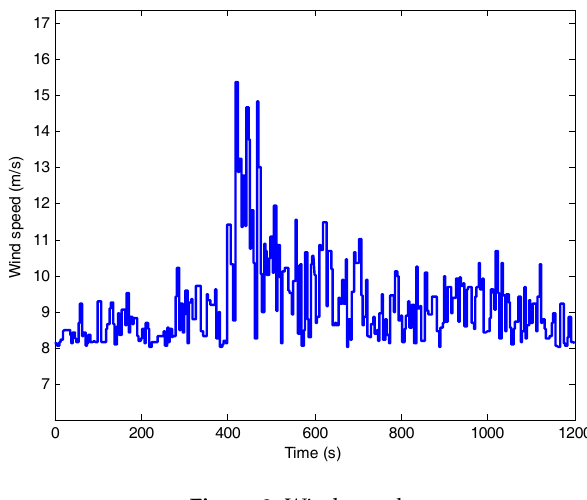
Figure 8. Wind speed.